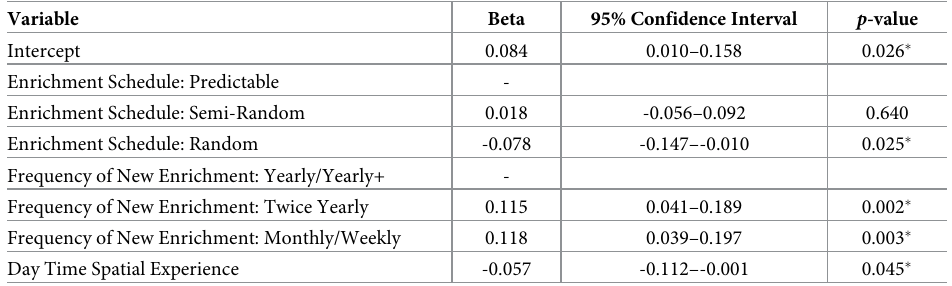
Table 9. Results from multivariate model examining interaction with conspecific ( � p < 0.05).